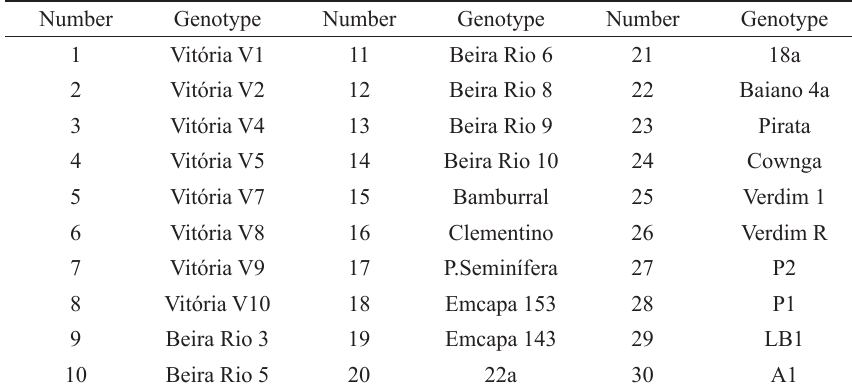
Coffea canephora genotypes evaluated in Vila Valério - ES, Brazil. Promising registered